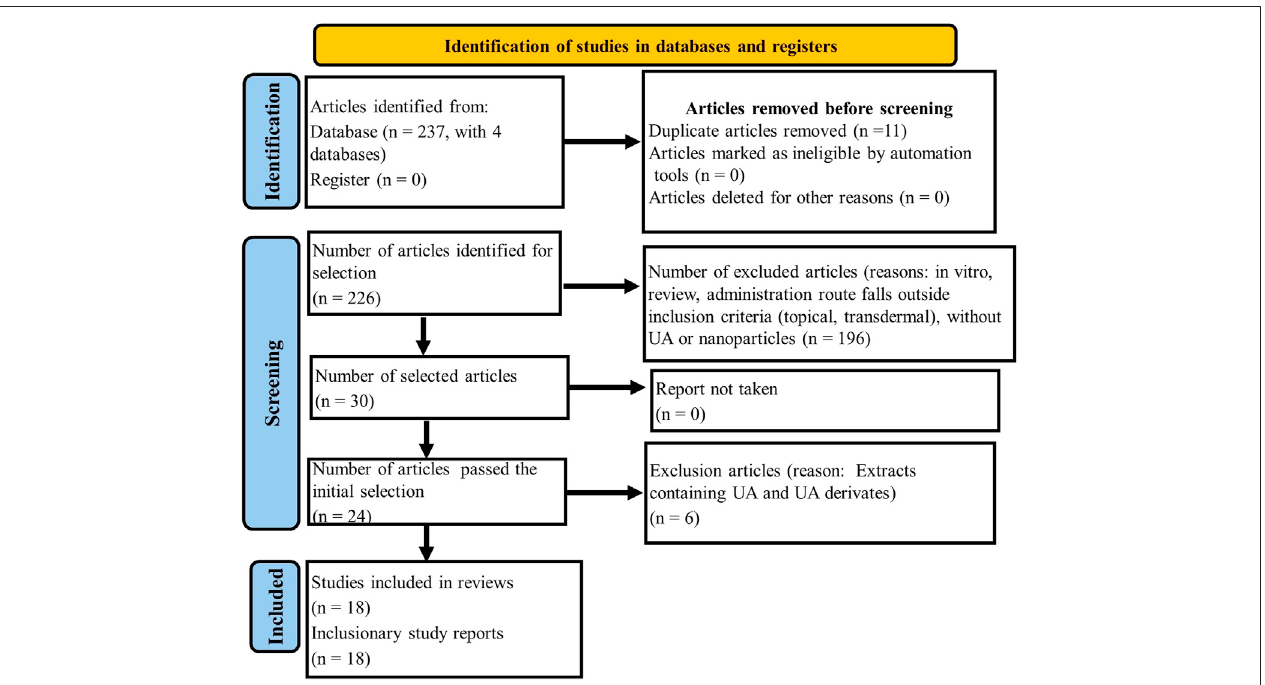
FIGURE 1 | Flow chart of PRISMA method for article identi fi cation, screening, and selection.